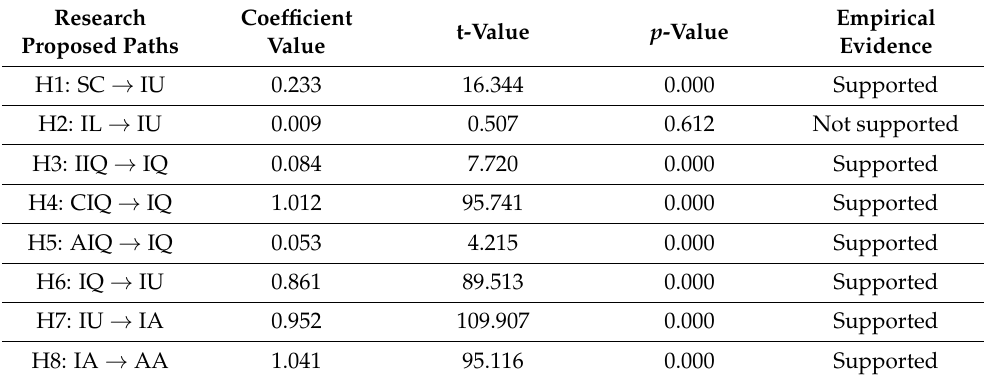
Table 7. Summary of the results for the research theoretical